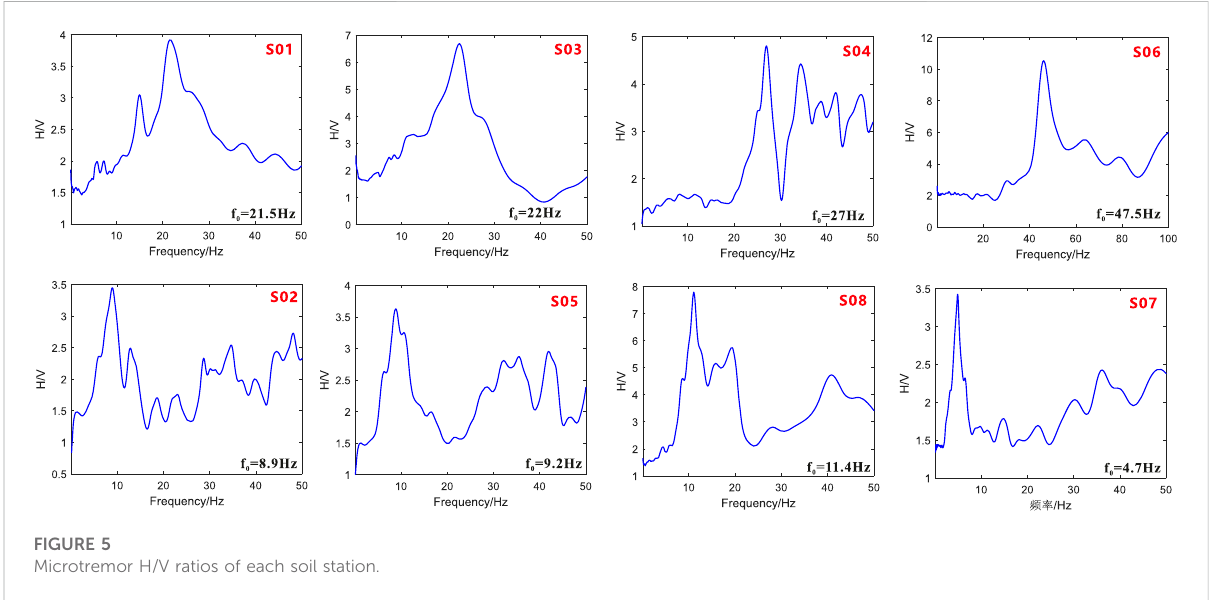
FIGURE 5 Microtremor H/V ratios of each soil station.